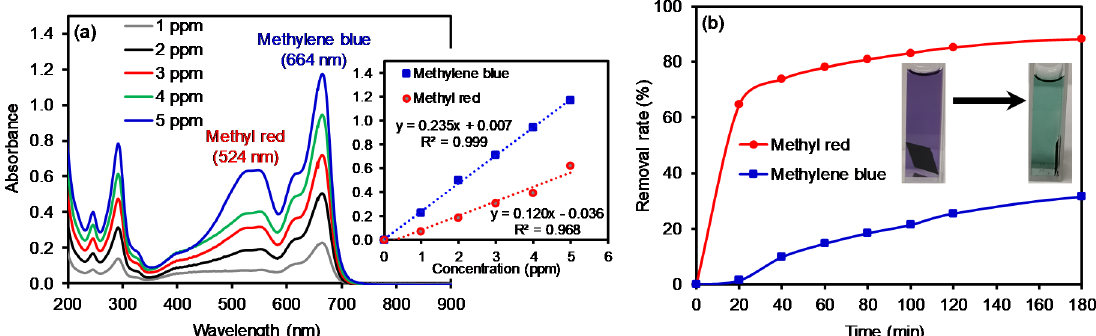
Figure 6. Absorption patterns ( a ) of a mixed solution of MB and MR (5 ppm each) as a function of concentration (inset: corresponding calibration curves) and the removal rate ( b ) of the mixed solution using the cGO20 PAN membrane as a function of time (inset: digital photos of typical color changes of the mixed dye solutions).